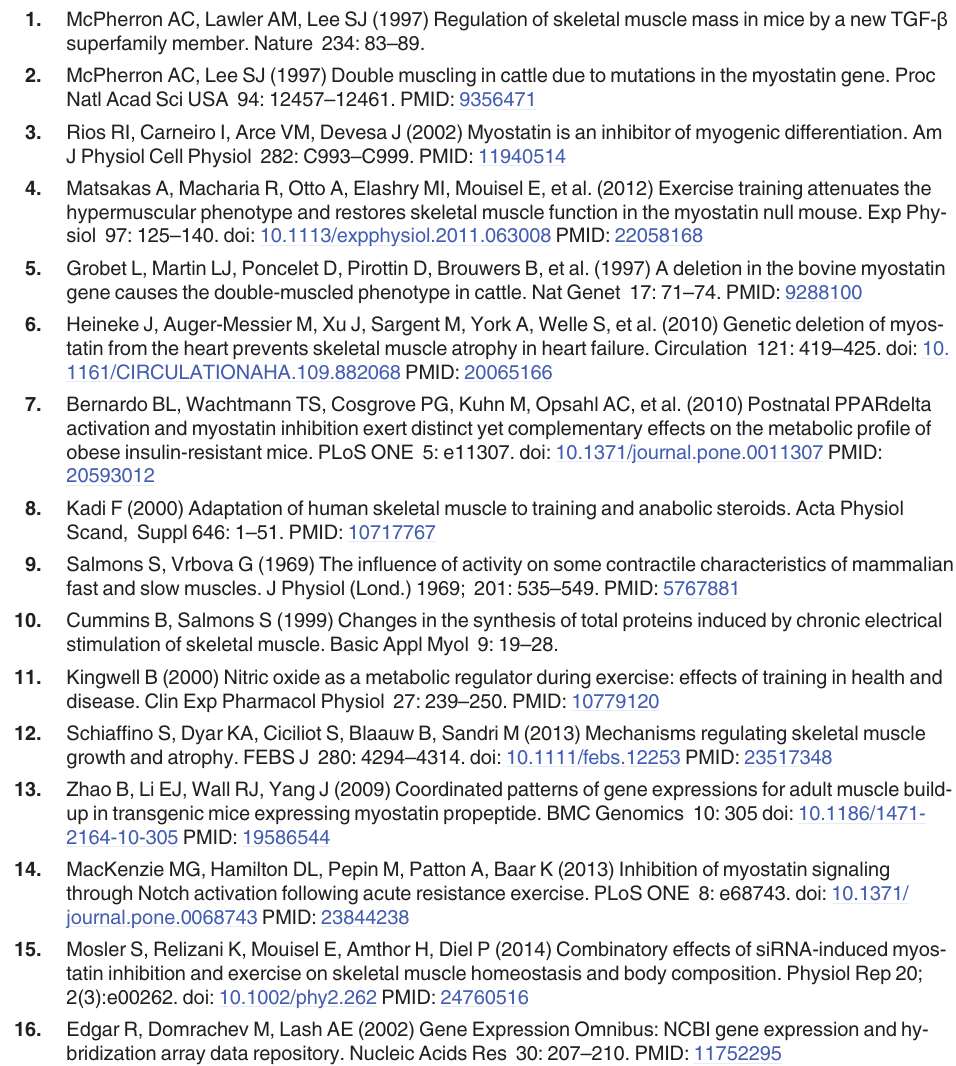
Table I: Genes differentially expressed (FDR-adjusted P-value < 0.01) between active and seden- tary mice in triceps brachii muscle. Table J: Enriched (enrichment score > 2) clusters of Gene Ontology (GO) biological process (BP), molecular function (MF) Functional Annotation Tool (FAT) categories, and KEGG path- ways among differentially expressed genes (FDR-adjusted P-value < 0.005) between triceps bra- chii muscle of active and sedentary